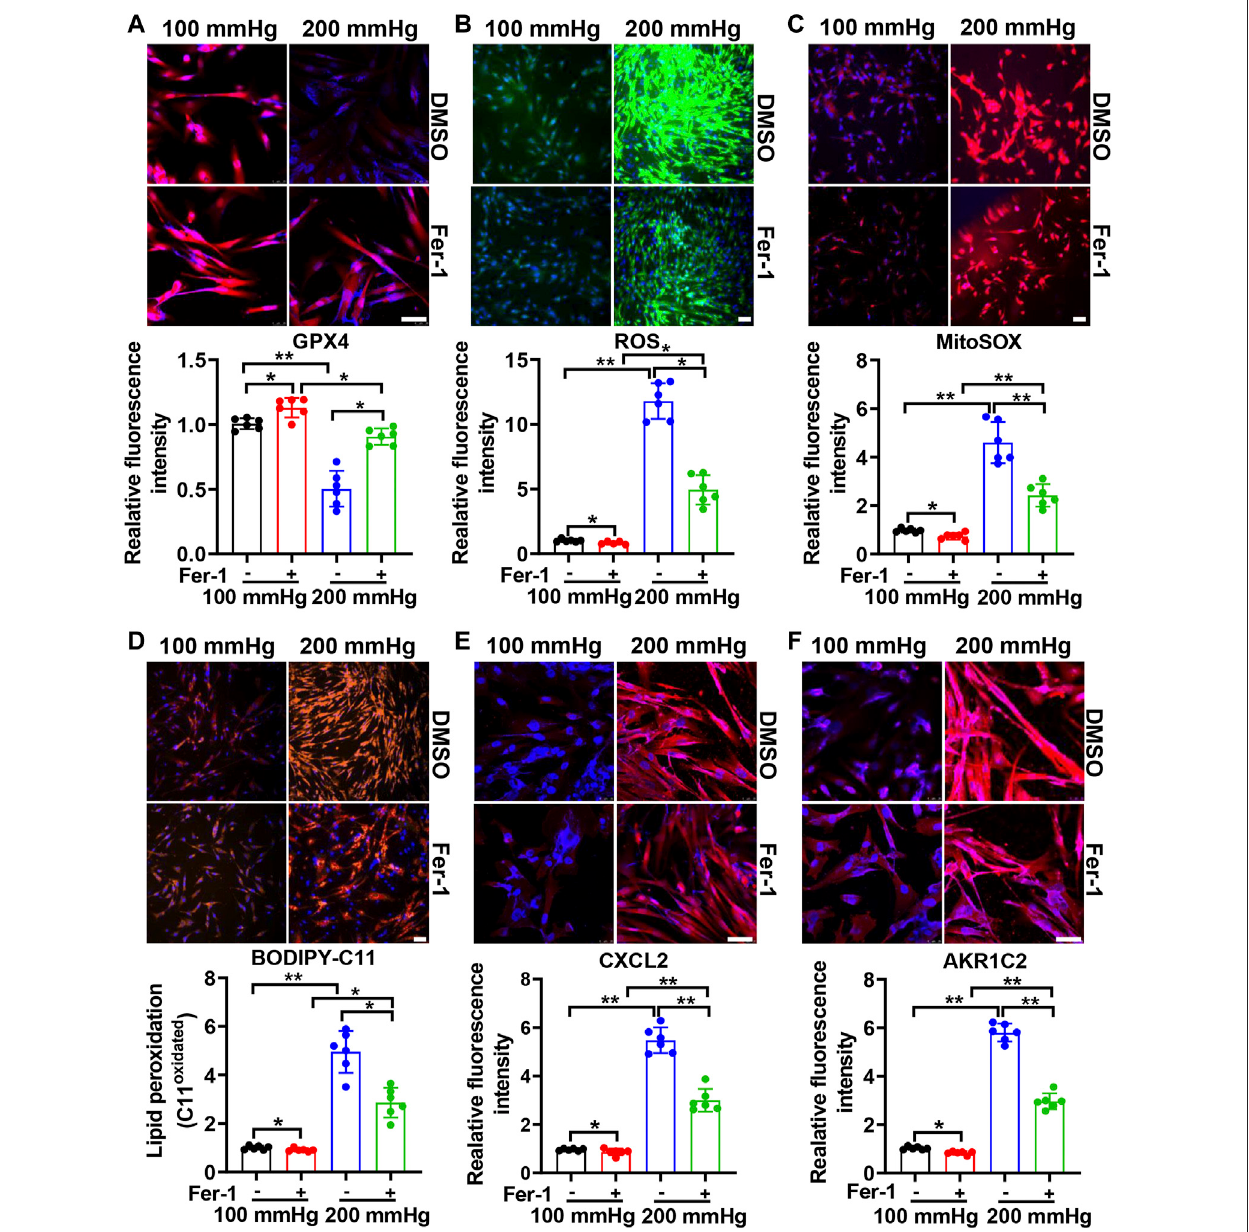
FIGURE 3 | Ferroptosis inhibitor Fer-1 mitigates the HHP-induced VSMC phenotype switch. HASMCs in a 100 mmHg or 200 mmHg incubator were treated with orwithout10 μ MFer-1for24 h.TheGPX4proteinlevelwasevaluatedbyimmuno fl uorescentstaining;theupperpanelistherepresentativeimage,andthelowerpanelis thestatisticalgraph (A) .ROSproductionwasdeterminedbytheROSstainingkit;theupperpanelistherepresentativeimage,andthelowerpanelisthestatisticalgraph (B) . Mitochondrial ROS was visualized by use of the fl uorescent probe MitoSOX Red (C) . BODIPY 581/591 C11 lipid oxidation in HASMCs was measured by immuno fl uorescent staining; the statistical graph is the oxidized (orange signal) BODIPY 581/591 C11 fl uorescence intensity (D) . Confocal images of the CXCL2 expression (E) and AKR1C2 expression (F) in HASMCs. Nuclei were counterstained with Hoechst. All scale bar = 50 μ M * p < 0.05, ** p < 0.01, *** p < 0.001.